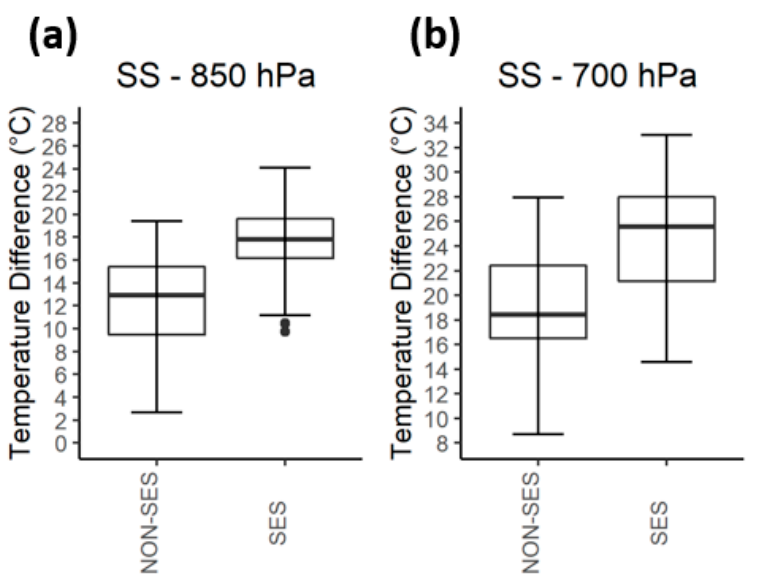
Figure 5. The variation in the temperature difference between the upper atmospheric level air (850 and 700 hPa levels) and point “B” (specified on the western Black Sea surface) in SES and non-SES events. ( a ) the temperature difference between the 850 hPa level and point “B”, ( b ) the temperature difference between the 700 hPa level and point “B”.